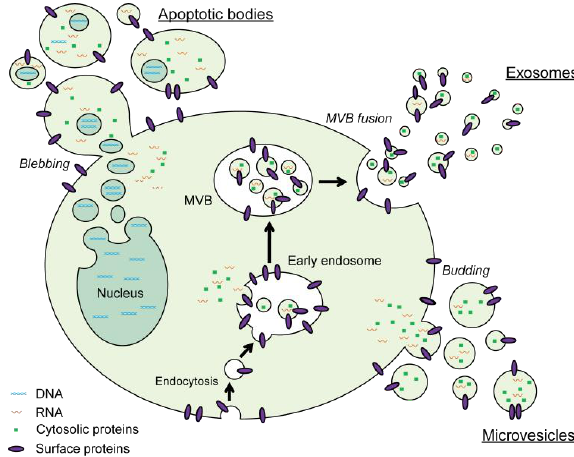
Figure 1. Schematic representation of the major pathways for biogenesis and secretion of extracellular vesicles (EVs). Exosomes are formed by inward budding of early endosomes and secreted by fusion of these multivesicular bodies with the plasma membrane. Microvesicles are created by direct outward budding of the plasma membrane. The vesicles that are generated upon programmed cell death-induced membrane blebbing are referred to as apoptotic bodies.